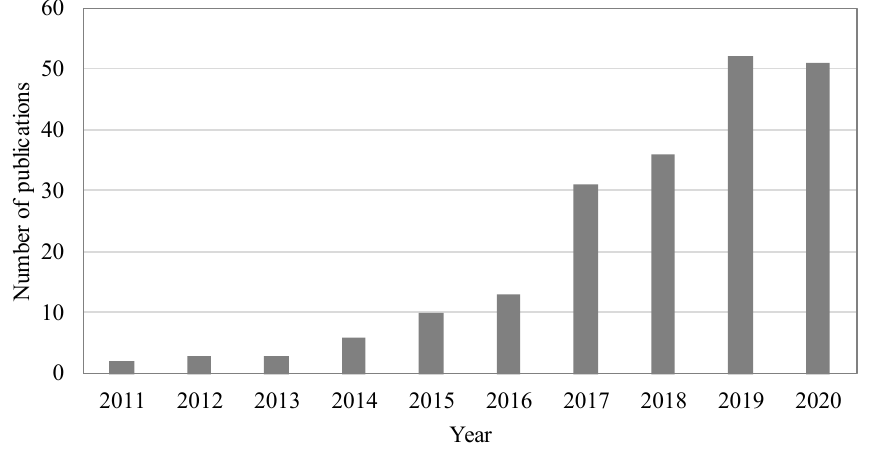
Figure 1. Description of LCZ types, containing 10 urban types on the outer circle and 7 natural types on the inner circle [7,18].